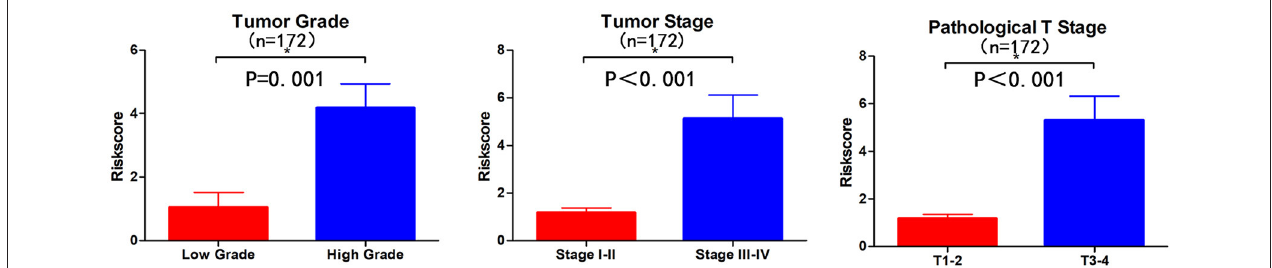
FIGURE 5 | Visualization of the clinical correlation between autophagy-related lncRNA model and patients with BC. The risk score is closely related to grade, union for international cancer control (UICC) stage, and pathological T stage (* p < 0.05).